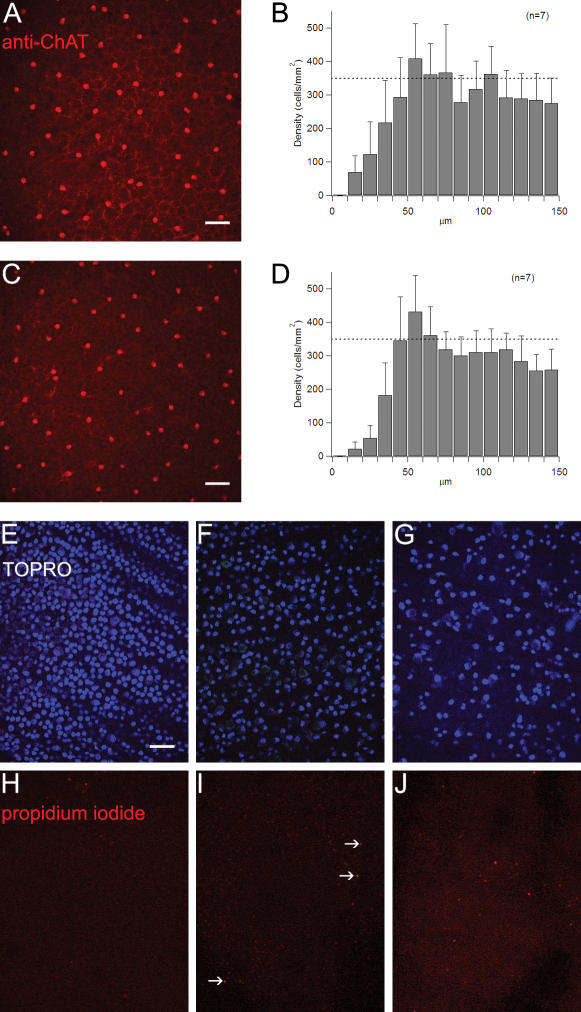
Viability of rabbit retina after six days of incubation.(A), Typical piece of rabbit retina stained with an antibody against ChAT (red) six after six days of incubation (focus on the ganglion cell layer). Seven such fields were measured to arrive at a density recovery profile (B) for starburst amacrine cells. Scale bar for A & C, 50 µm. (C), matched field with focus on the inner nuclear layer (OFF starburst amacrine cells). (D), density recovery profile for starburst amacrine cells in the INL. (E, F, and G), ganglion cell layer of rabbit retina incubated for six days stained for dead cells (propidium iodide, red), cells in the process of apoptosis (YO-PRO, bright green) and counterstained with the nuclear dye TOPRO (blue). No dead or dying cells are visible in the ganglion cell layer in central retina (panel E), mid-periphery (panel F), and peripheral retina (panel G). (H, I, and J) show matched fields with the focus on the photoreceptor cell bodies. Several cells are labeled by their incorporation of propidium iodide (arrows), indicating cell death in the photoreceptor layer. Scale bar for panels E–J, 50 µm.